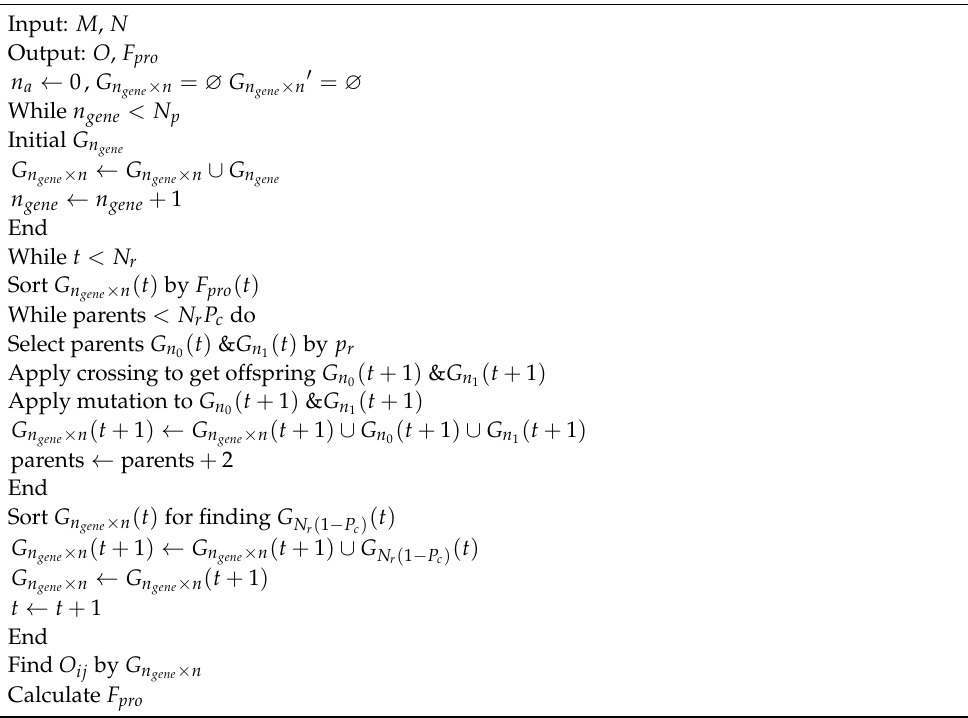
Algorithm 3: GA for the Placement